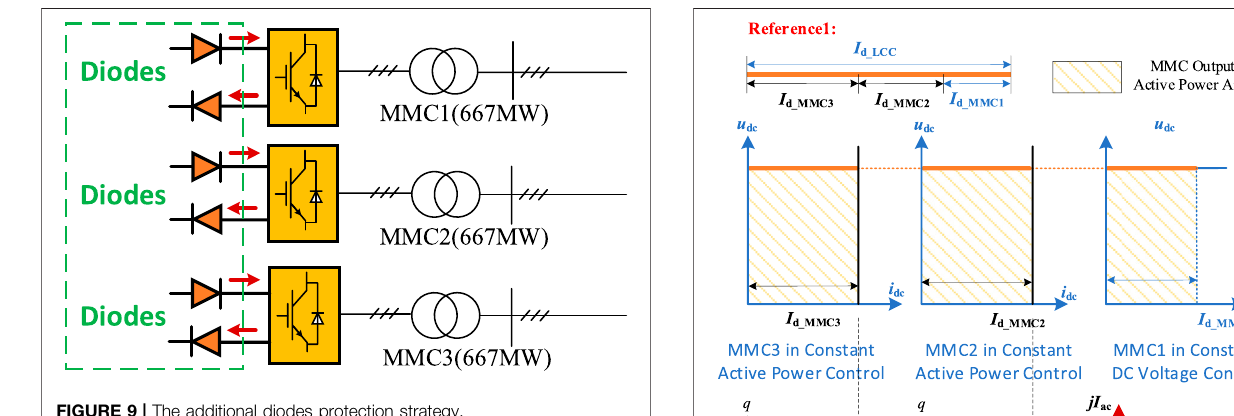
FIGURE 9 | The additional diodes protection strategy.